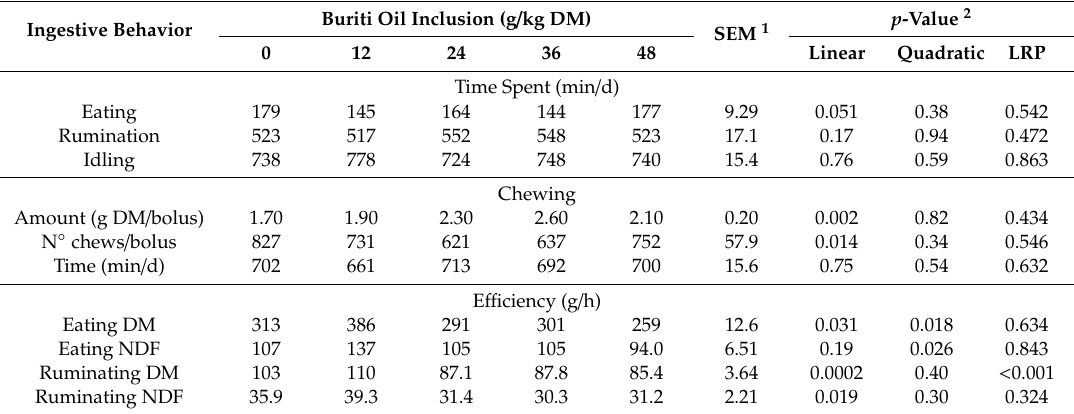
Table 4. Ingestive behavior of Santa Ines lambs fed diets with buriti ( Mauritia flexuosa L .) oil. Ingestive